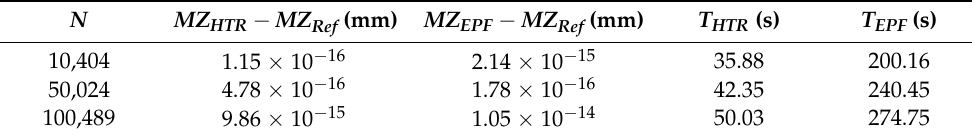
Table 4. Values of MZ-MZ ref and execution time (s) for HTR and EPF (configuration